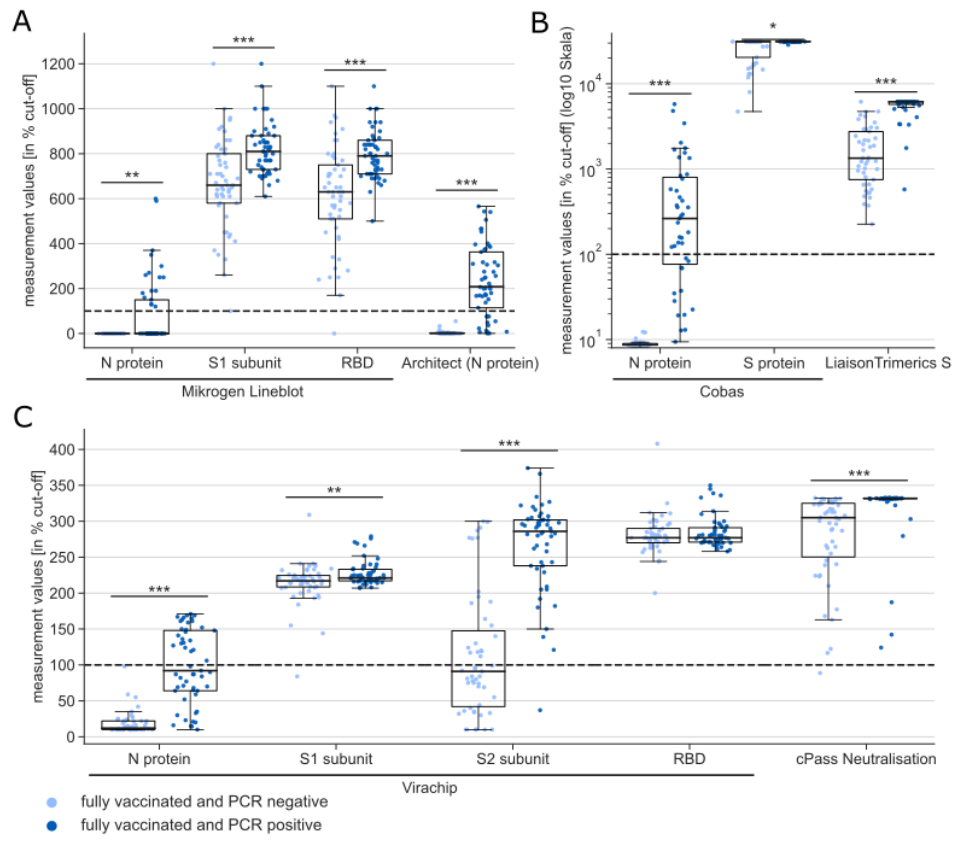
Figure 2. Measurements of all antibody assays performed represented as percent of the cut-off value (indicated by dashed line), subdivided by infection status (PCR positive: dark blue, PCR negative light blue). Wilcoxon rank sum test with *: p < 0.05, **: p < 0.01, ***: p < 0.001. ( A ) Mikrogen Lineblot with antigens: N protein, S1 subunit and RBD, Architect with N protein as antigen, ( B ) Cobas N Protein, Cobas S Protein and Liaison TrimericS S Protein, plotted on a logarithmic scale for better representation of the wide range of measured values, and ( C ) Virachip with N protein, S1 subunit, S2 subunit and RBD as antigens and cPass surrgat neutralization